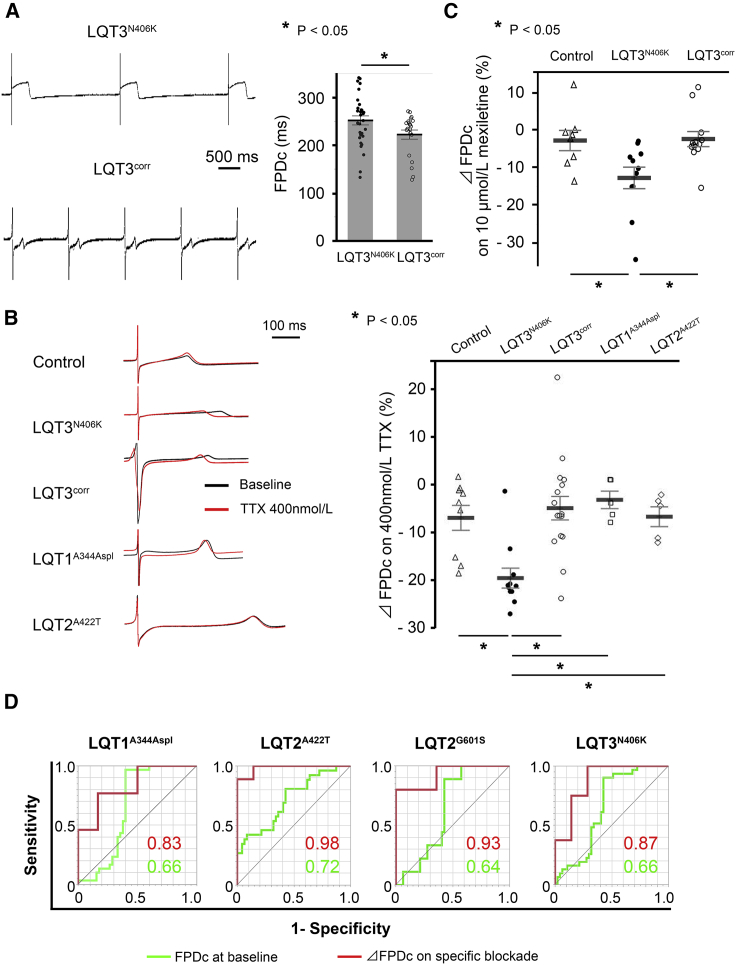
Functional Analysis of iPSC-CMs Using MEA Following INa Blockade(A) Representative traces of FP in LQT3N406K- and LQT3corr-iPSC-CMs (left). FPDc at baseline in LQT3N406K-iPSC-CMs was significantly shortened by gene correction (right) (independent experiments, n = 36 and 29 from independent differentiation experiments, n = 8 and 8 in LQT3N406K- and LQT3corr-iPSC-CMs, respectively; mean ± SEM; p < 0.05; unpaired Student's t test). ∗p < 0.05.(B) Representative traces of the FP following administration of 400 nmol/L (red) TTX in Control-, LQT3N406K-, LQT3corr-, LQT1A344Aspl-, and LQT2A422T-iPSC-CMs (left). The response to treatment with 400 nmol/L TTX was significantly larger in LQT3N406K-iPSC-CMs than in Control-, LQT3corr-, LQT1A344Aspl-, and LQT2A422T-iPSC-CMs (right) (independent experiments, n = 9, 11, 17, 5, and 5 from independent differentiation experiments, n = 4, 5, 4, 3, and 3 in Control-, LQT3N406K-, LQT3corr-, LQT1A344Aspl-, and LQT2A422T-iPSC-CMs, respectively; mean ± SEM; p < 0.001; one-way ANOVA). ∗p < 0.05; Fisher's LSD post hoc test.(C) Averaged %ΔFPDc on 10 μmol/L mexiletine in Control-, LQT3N406K-, and LQT3corr-iPSC-CMs (independent experiments, n = 7, 11, and 12 from independent differentiation experiments, n = 3, 3, and 5, respectively; mean ± SEM; p < 0.001; one-way ANOVA). ∗p < 0.05; Fisher's LSD post hoc test.(D) Comparison of AUCs for baseline FPDc and %ΔFPDc upon specific current blockade for recognizing disease-specific iPSC-CMs. Specific current blockade enhanced the accuracy of recognizing disease-specific iPSC-CMs.See also Table S1.